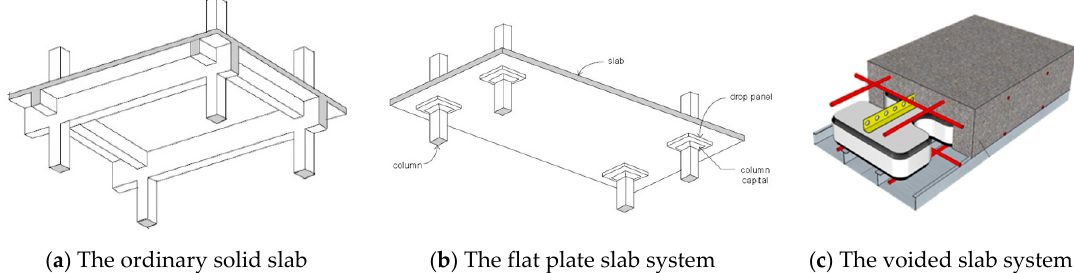
Figure 4. Schematics of the slab systems.